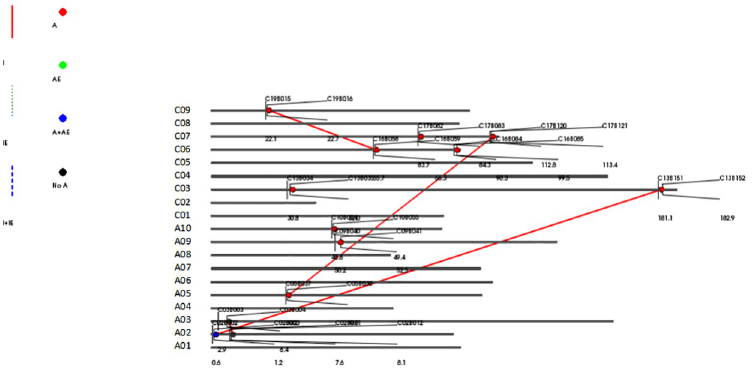
Fig 3. Distribution of epistatic loci for SD. The numbers and letters on the left represent chromosomes, the numbers and letters in the figure represent the QTL intervals, the red dots represent additive effect sites, the blue dots represent the interaction effects of plus × plus and the environment, the black dots represent no additive correlation effects, and the red lines represent only epistatic effects.